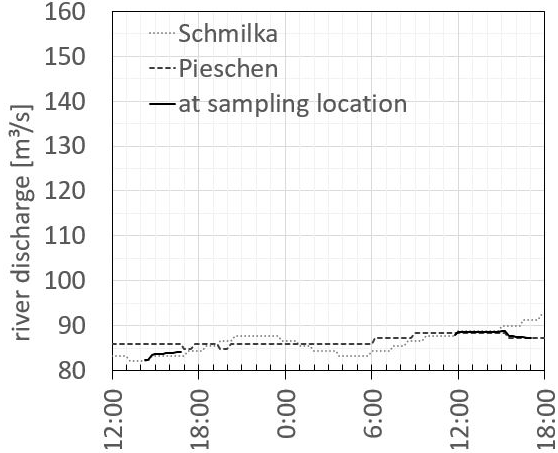
Figure 4. River discharge (i) recorded at stations in Schmilka and Pieschen and (ii) interpolated for the sampling location of the cruising vessel during the first cruise (with the first data point located 4 km downstream of Schmilka) (13–14 August 2018).